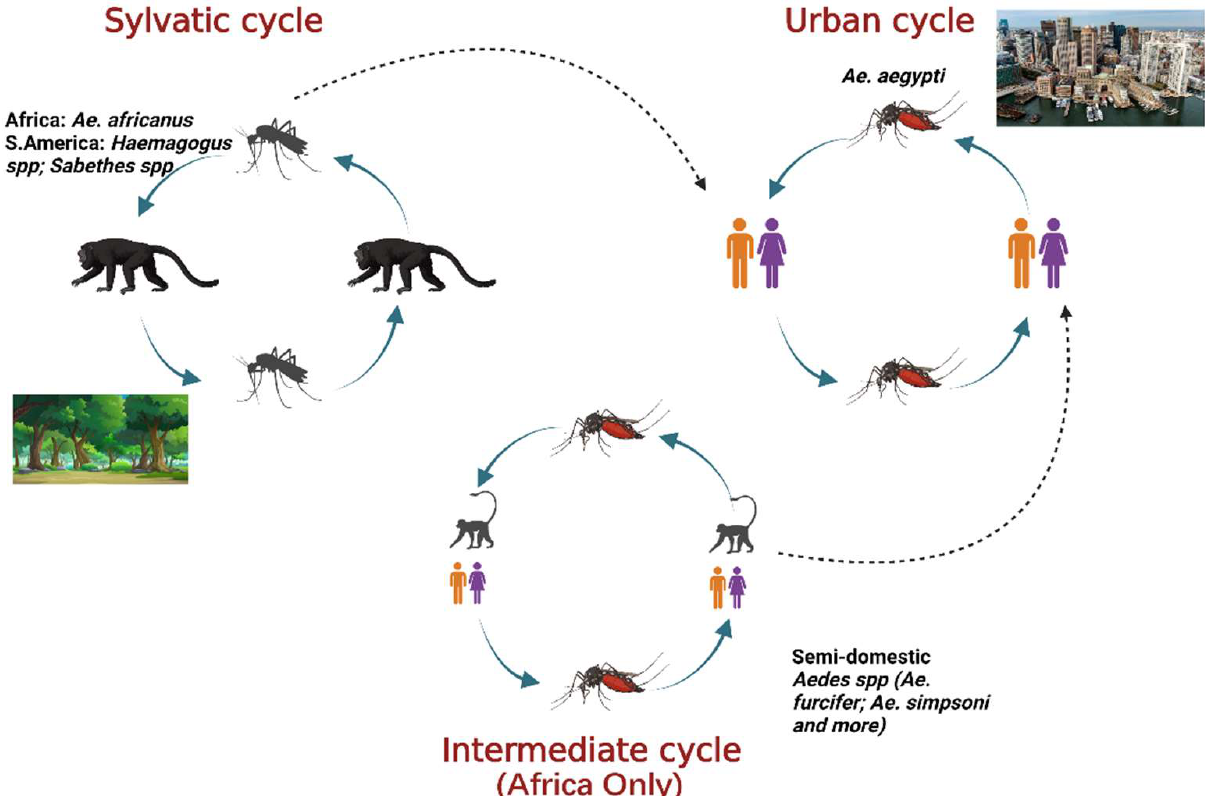
Figure 1. The three cycles for YFV transmission involve various mosquito species and hosts. In the sylvatic cycle, the YFV is maintained between sylvatic mosquito species and NHPs as host. In the urban cycle, the virus is primarily maintained between Ae. aegypti mosquitoes and humans as host. The intermediate cycle occurs in Africa only in moist savannah regions with small human settle- ments. The virus can be transmitted from semi-domestic mosquitoes to humans or NHPs as host. Adapted from CDC (created with Biorender.com, accessed on 1 July 2022).